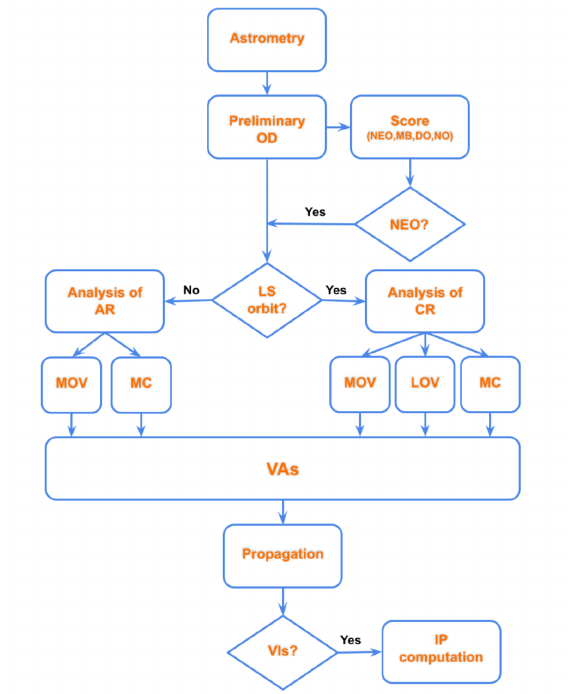
Figure 7. Figure from [47]. A flow diagram concerning a possible new approach with the IM